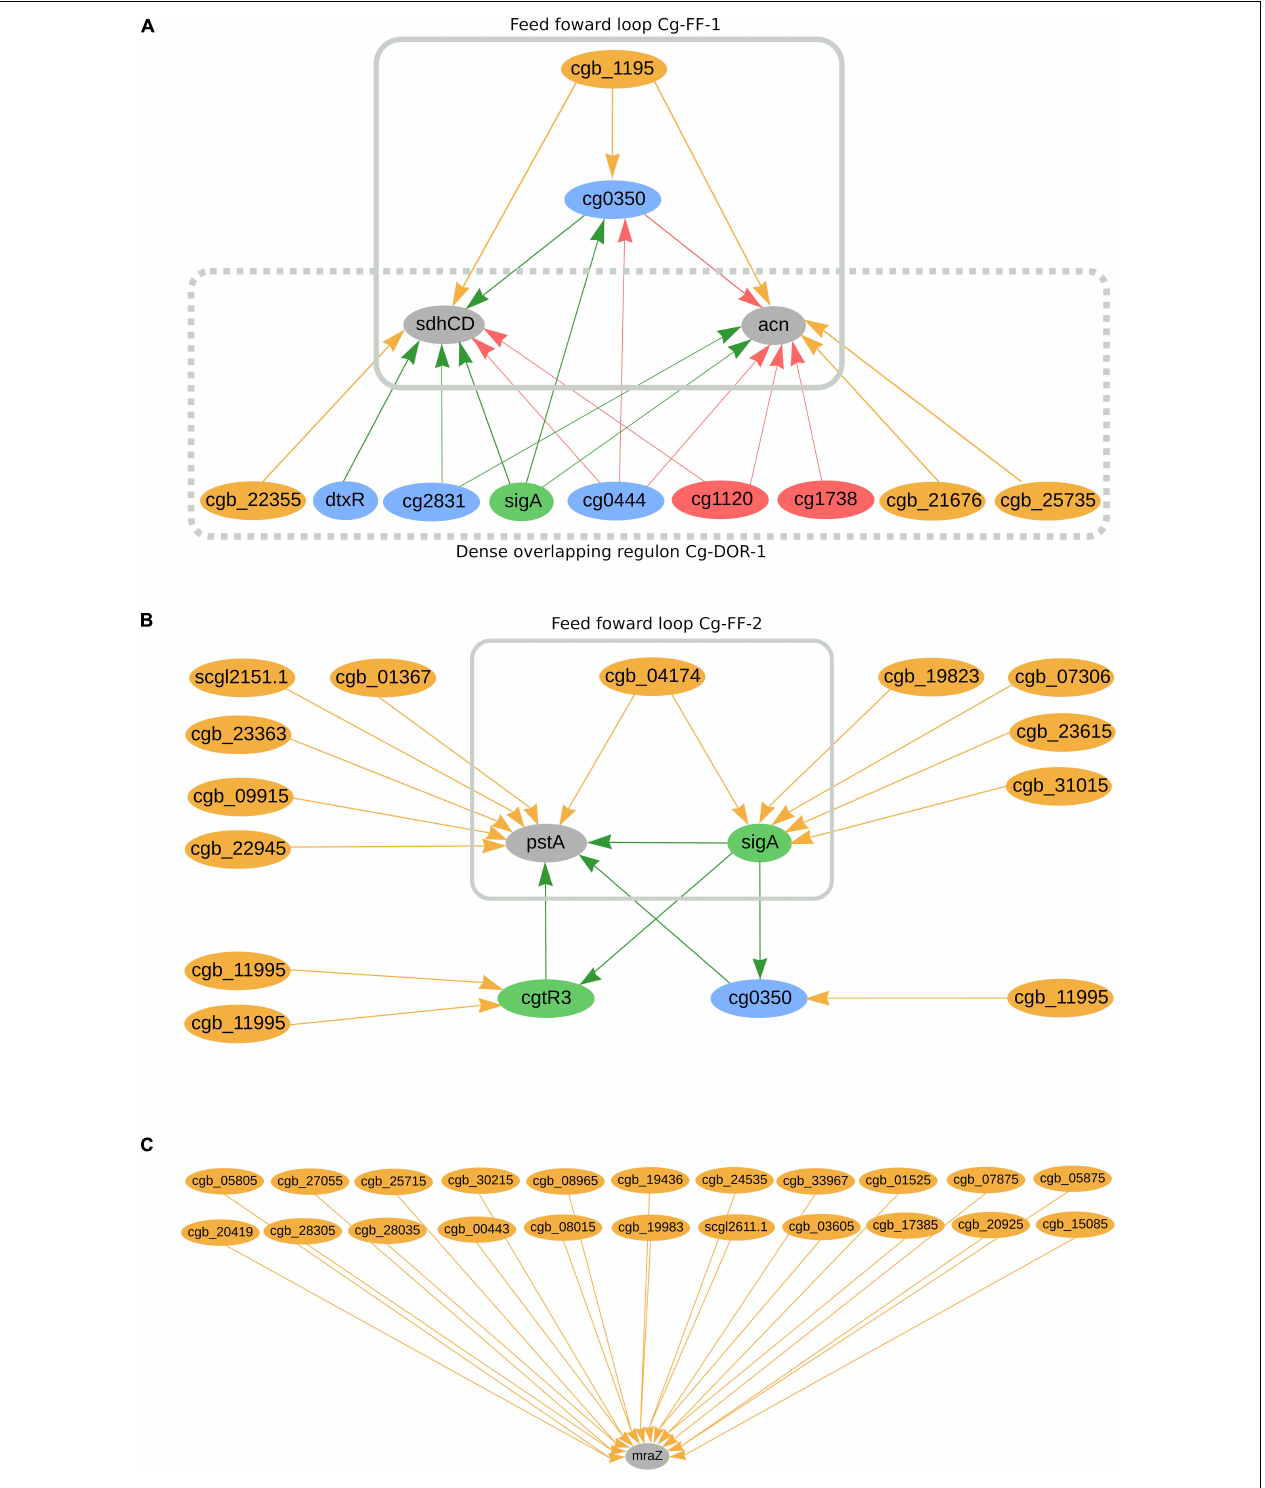
FIGURE 4 | C. glutamicum ’s predicted sRNA-enriched regulons. (A) sdhCC and acn co-regulated by TFs and sRNAs and forming two regulatory circuits, Cg-DOR-1 and Cg-FF-1. (B) pstA being directly and indirectly regulated by TFs and sRNAs, forming the regulatory circuit Cg-FF-2. (C) marZ being regulated by 22 sRNAs. In the networks, green nodes represent activator proteins, red nodes represent repressor proteins, blue nodes represent dual regulators (i.e., that can activate and repress gene expression), orange nodes represent sRNAs and gray nodes represent target genes. The arrows represent the regulatory interactions and their colors represent the same roles as the ones in the